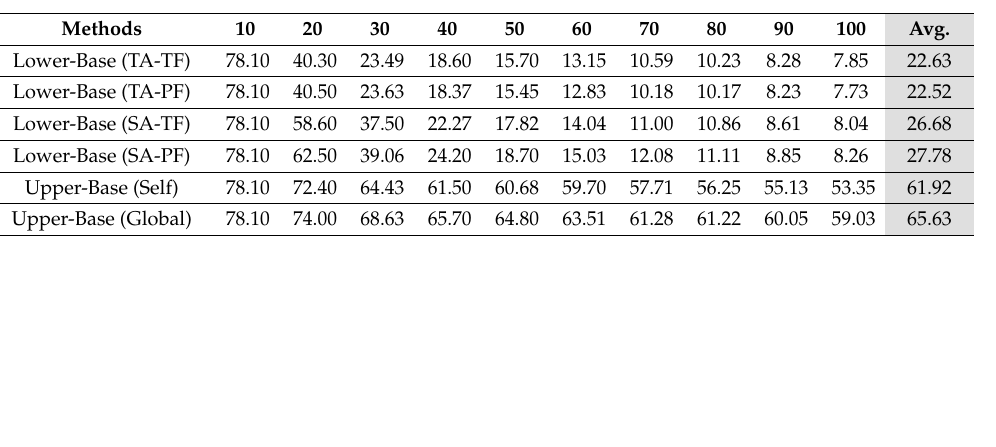
Table 5. Tiny-ImageNet: Comprehensive performance on sparse